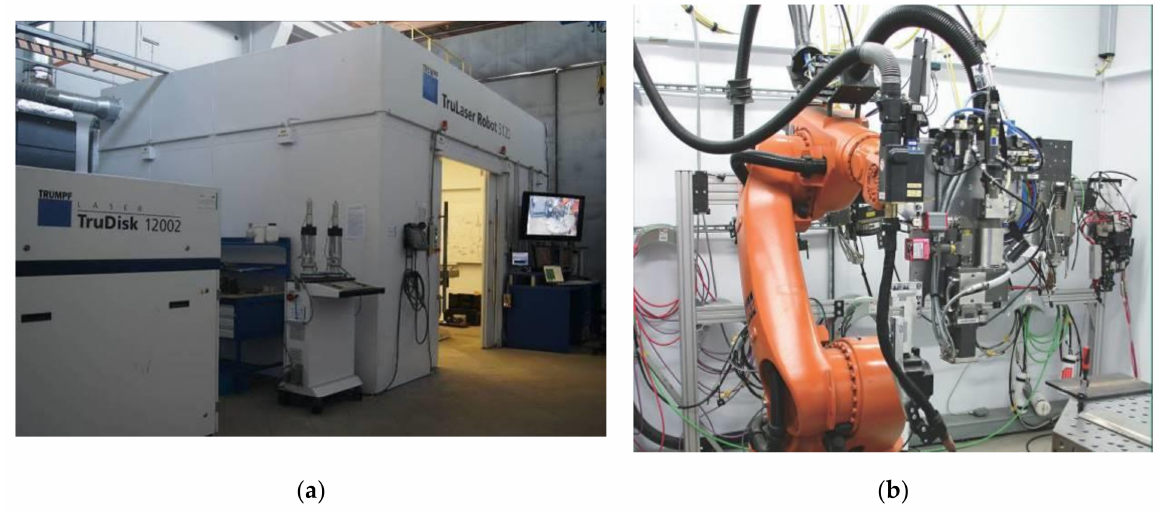
Figure 3. Robotic laser welding station (TruLaser Robot 5120) with the TruDisk 12002 disc laser: ( a ) main view, ( b ) D70 hybrid-welding head (Trumpf) (Łukasiewicz Research Network—Institute of Welding in Gliwice). The welding tests were performed in two positions, i.e., in the flat position (PA) (Figure 4a) and in the horizontal position (PC) (Figure 4b). The edges of the plates to be joined were subjected to square butt weld preparation and set up without a gap (b = 0) at the